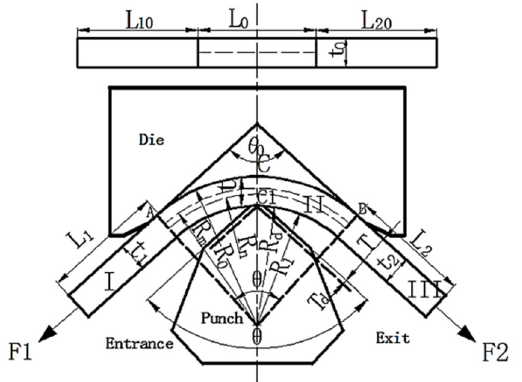
Figure 2. Geometric parameters and area division of strip CSPB forming process.